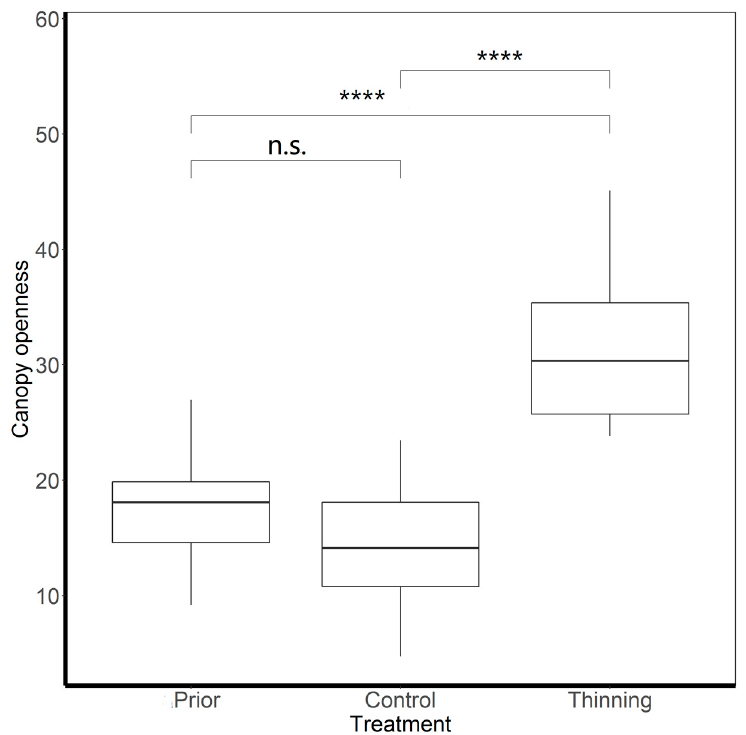
Figure 8. Canopy openness for different management types: prior (before thinning, n = 24), Control (the control plots, n = 12), and thinning (thinning plots, n = 12). Box plots showing canopy openness for the differences before thinning (prior) and after management (control, thinning), and for the differences of different management (control, thinning). **** indicate significant differences ( p < 0.01), Non-significant are marked by the abbreviation “n.s.”.